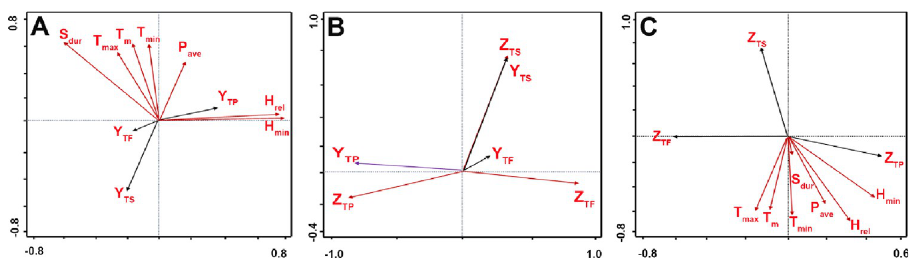
Fig 5. Redundancy analysis (RDA) plots on the contents of secondary metabolites, DPPH radical scavenging rates and environmental factors. (A) Contents of secondary metabolites and environmental factors; (B) DPPH radical scavenging rates and contents of secondary metabolites; (C) DPPH radical scavenging rates and climatic factors. P ave , T m , T max , T min , H rel , H min and S dur indicated in Fig 1; Y TPH , Y TS and Y TP indicated in Fig 1; Z TPH , Z TS and Z TP indicated in Table